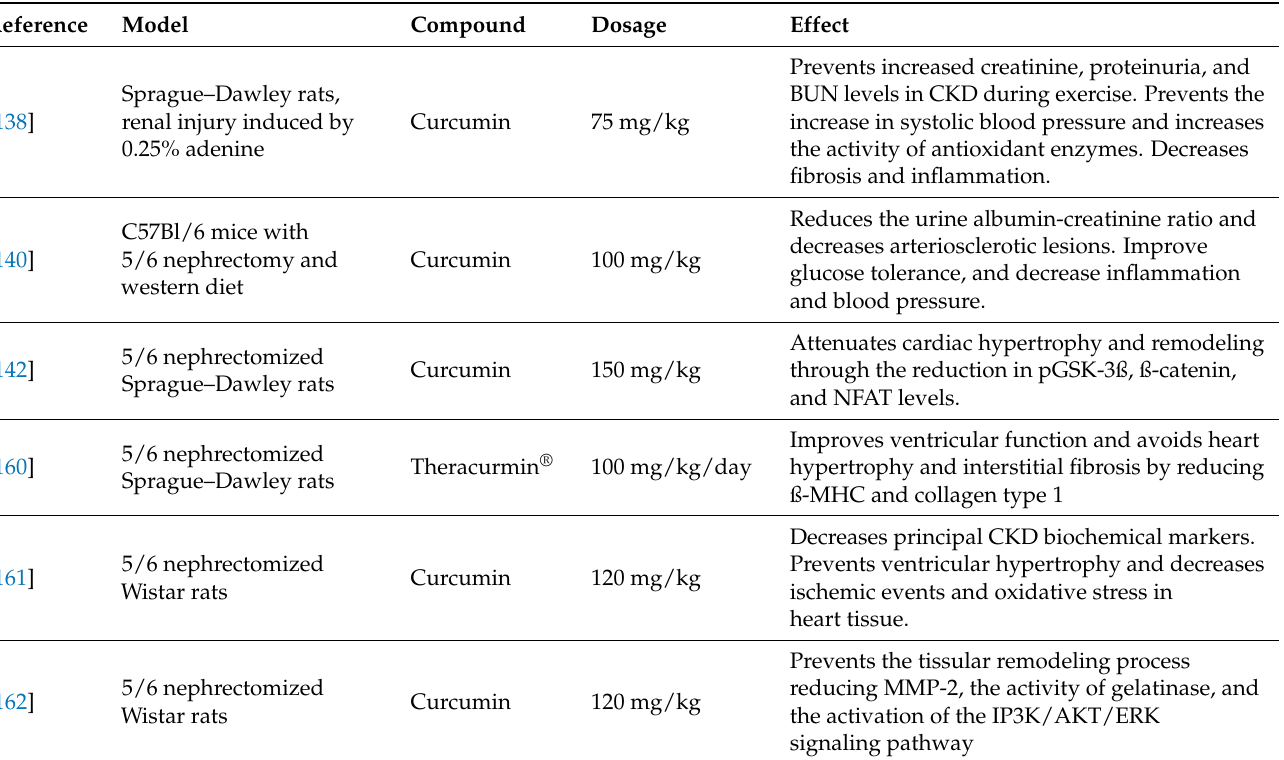
Table 3. Curcuminoids’ effects on chronic kidney disease (CKD)-induced cardiovascular